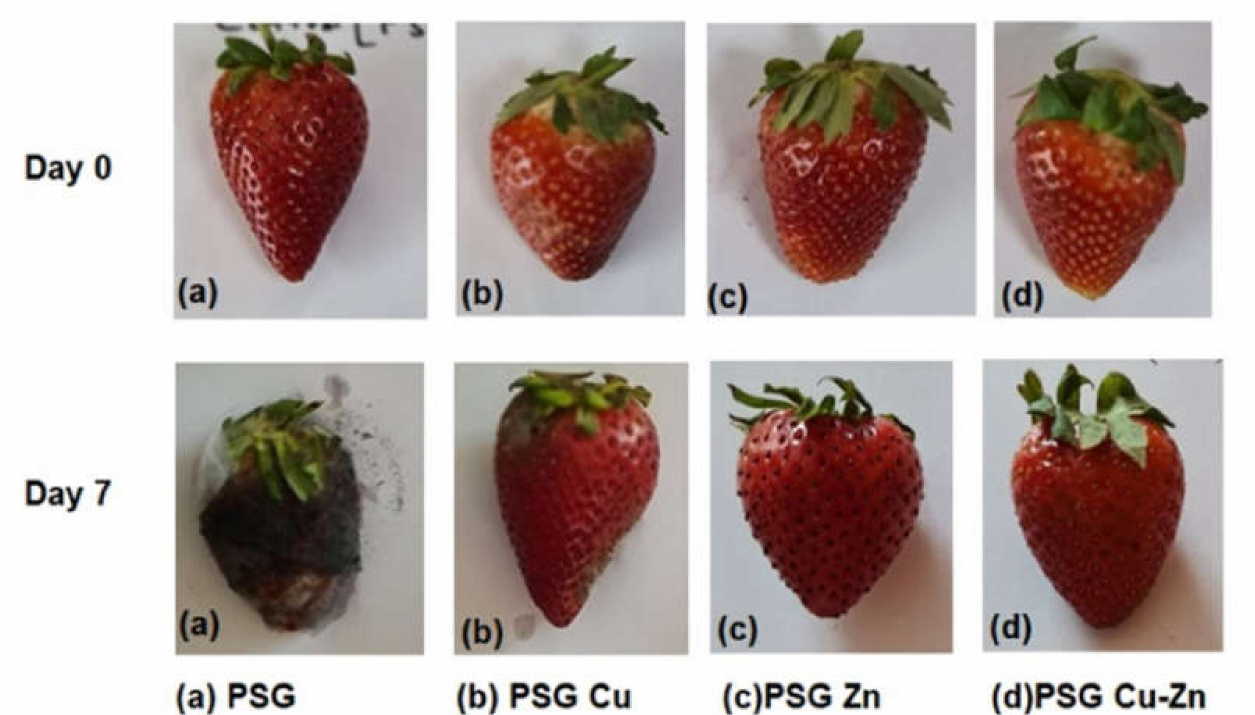
Figure 10. Comparison between the appearance of strawberries wrapped with PSG, PSG–Cu, PSG– Zn, and PSG–CuZn films on day 0 and day